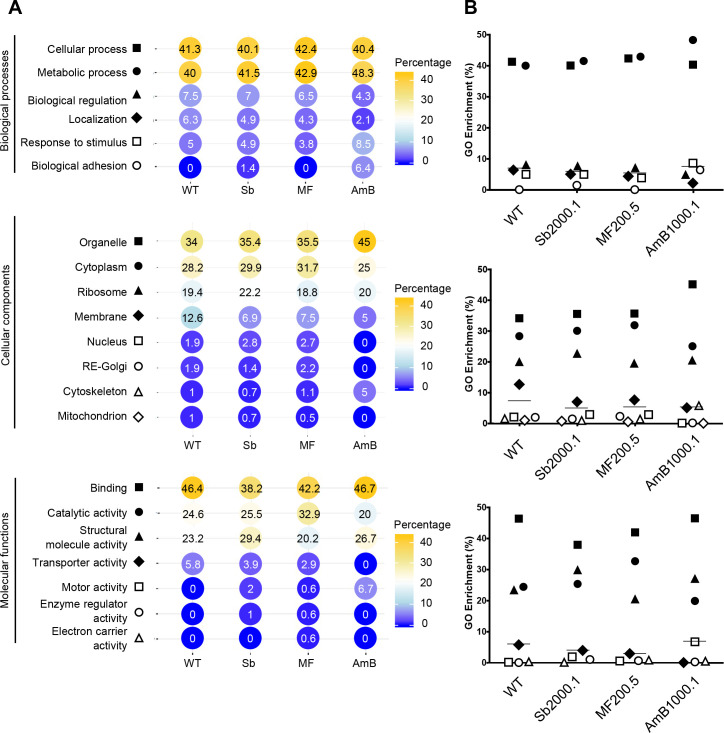
GO analysis of proteins shared by L. infantum WT and drug-resistant strain EVs.(A) Shared proteins among the three replicates of each strain (WT: 152; Sb2000.1: 194; MF200.5: 264; and AmB1000.1: 70 proteins) were annotated with GO terms from UniProt GOA knowledge base using the basic Scaffold version 4.11.0. GO terms were classified according to Biological Process, Cellular Component and Molecular Function, as defined by the GO consortium. (B) General distribution of the GO hits identified in (A). Horizontal lines indicate the median values.